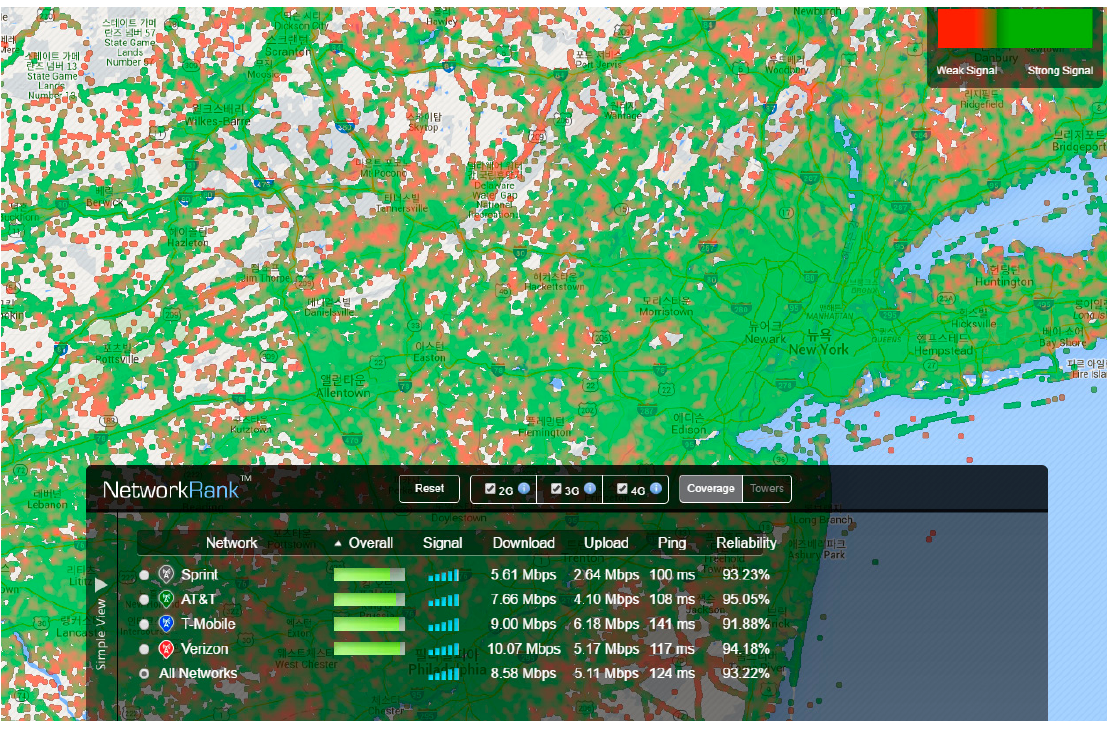
Figure 1. Example of network coverage data provided by OpenSignal.